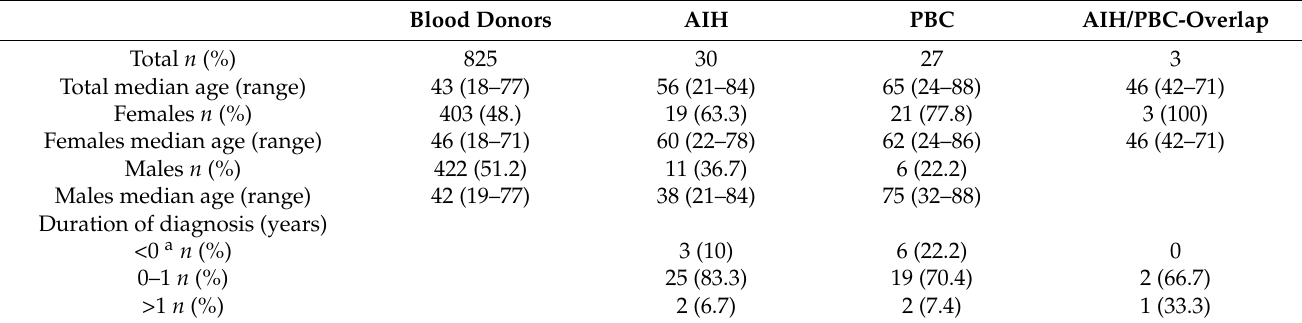
Table 1. Demographics and duration of